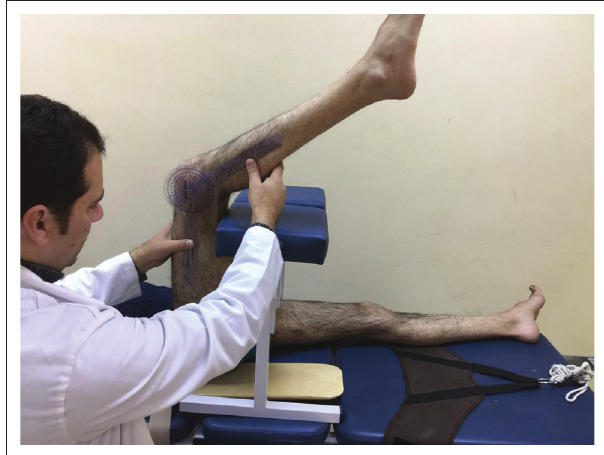
FIGURE 1: Measuring hamstring muscle flexibility through knee extension range of